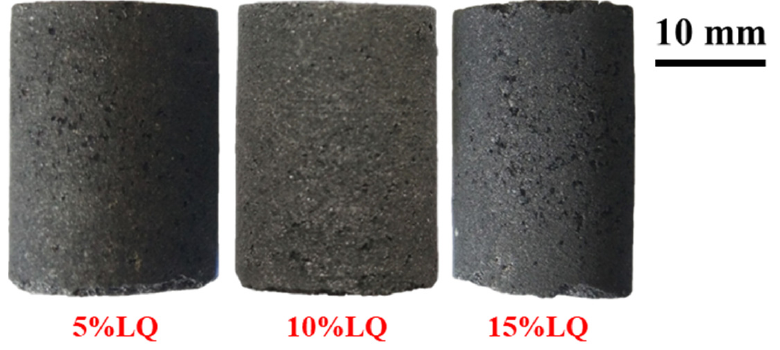
Figure 15. Macroscopic morphology of ferro-coke with different amounts of coal-tar pitch.